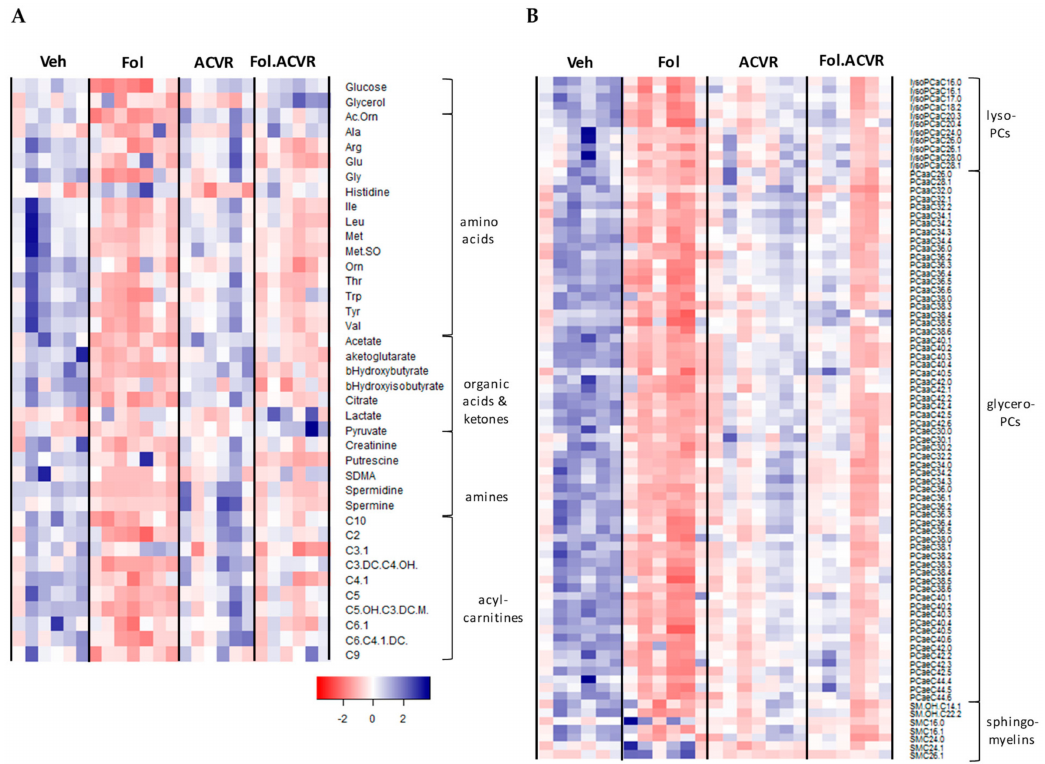
Figure 1. ( A ) Heatmap of serum metabolites including glucose, glycerol, amino acids, organic acids and ketones, amine, and acylcarnitines from mice treated with vehicle, Folfiri (Fol), ACVR2B / Fc, (ACVR), and the combination Folfiri plus ACVR2B / Fc (Fol.ACVR). Only metabolites that demonstrated at least one significant intergroup di ff erence as evaluated by one-way ANOVA with Tukey’s multiple testing correction and p -value less than 0.05 are shown. ( B ) Heatmap of lipids including lysophospholipids (lysoPCs), glycerophospholipids (PCs), and sphingomyelins. A total of 130 metabolites are shown as z-scores in the